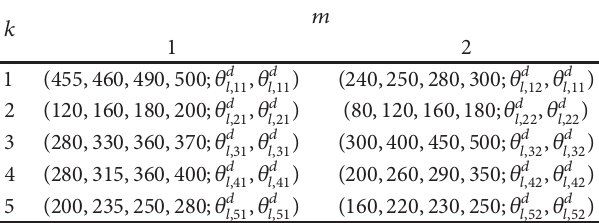
Table 6: Parameters related to demands of different affected